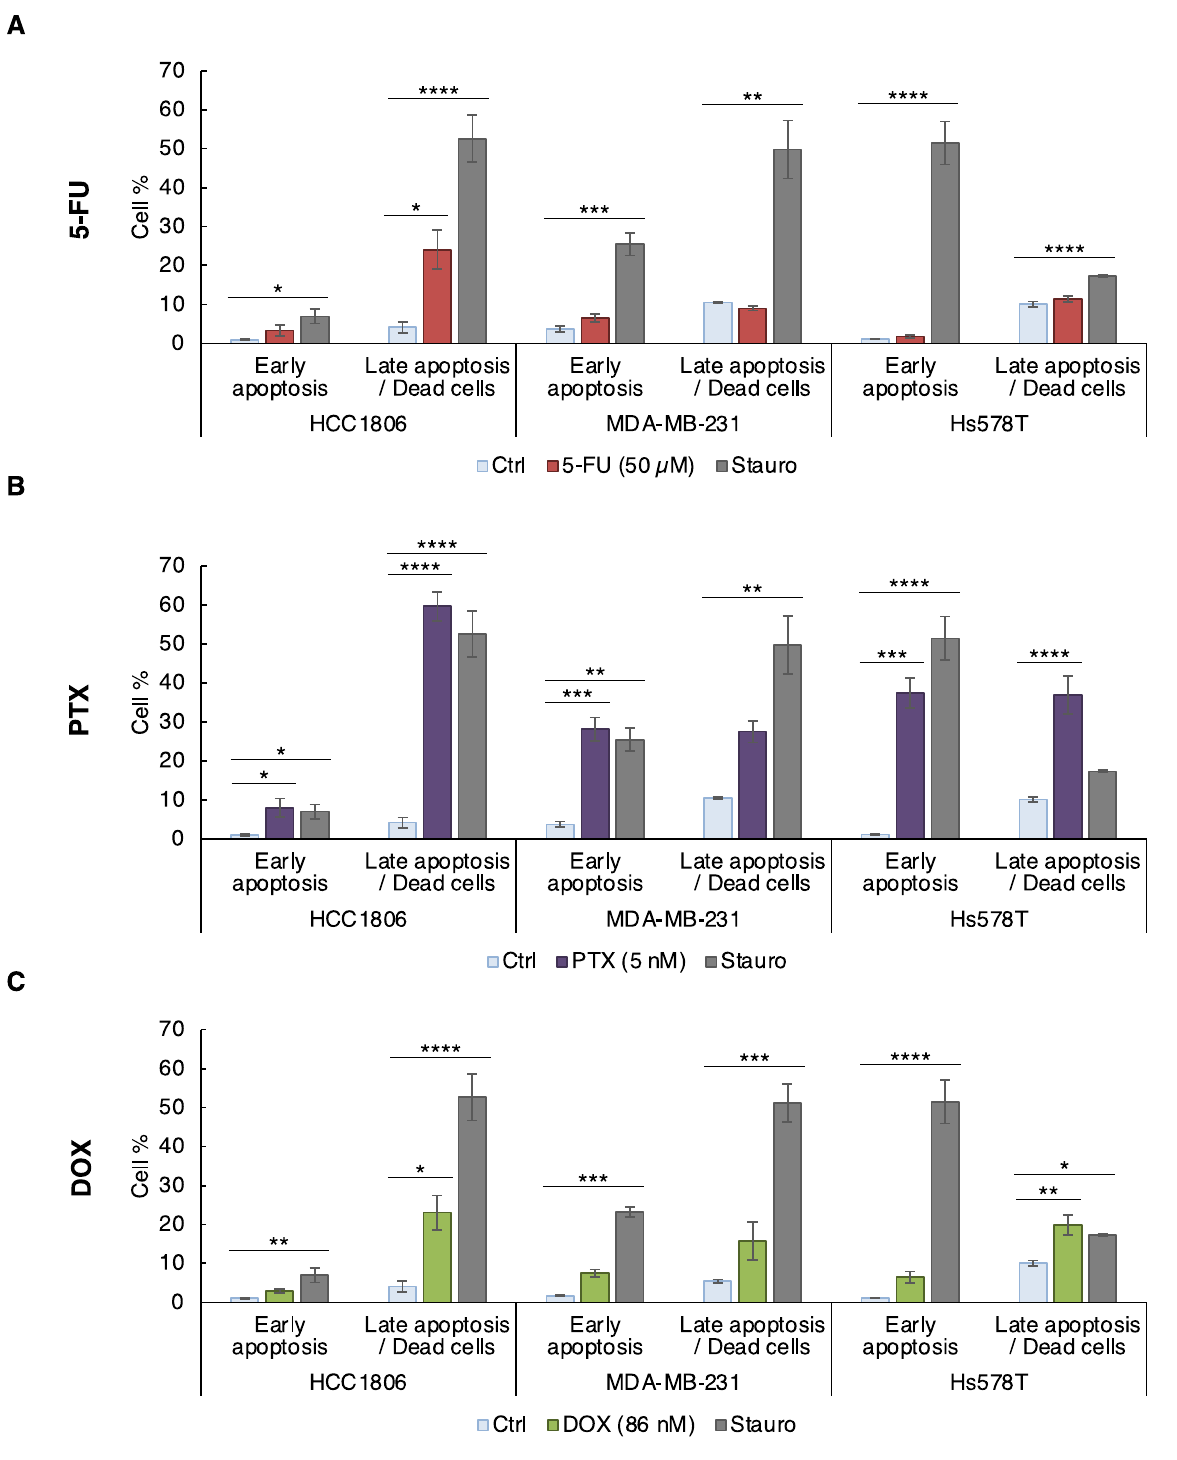
Figure 3. Chemotherapy induced more apoptosis in HCC1806 “claudin-1-high” cells than in “claudin-1-low” cells. HCC1806, MDA-MB-231 and Hs578T cells were treated with ( A ) 50 µM of 5-FU, ( B ) 5 nM of PTX and ( C ) 86 nM of DOX or with solvent (Ctrl) for 72 h. Cells were treated with Staurosporine (Stauro), used as a positive apoptosis induction control, at 50, 500 and 100 nM for each cell line, respectively. The cells are co-labeled with annexin V coupled to FITC and with propidium iodide and the living, early- and late-apoptotic cells were analyzed by flow cytometry. The values represent the means ± SEM of three to four different experiments. A p -value of less than 0.05 was considered statistically significant with * p < 0.05, ** p < 0.01, *** p < 0.001, **** p <